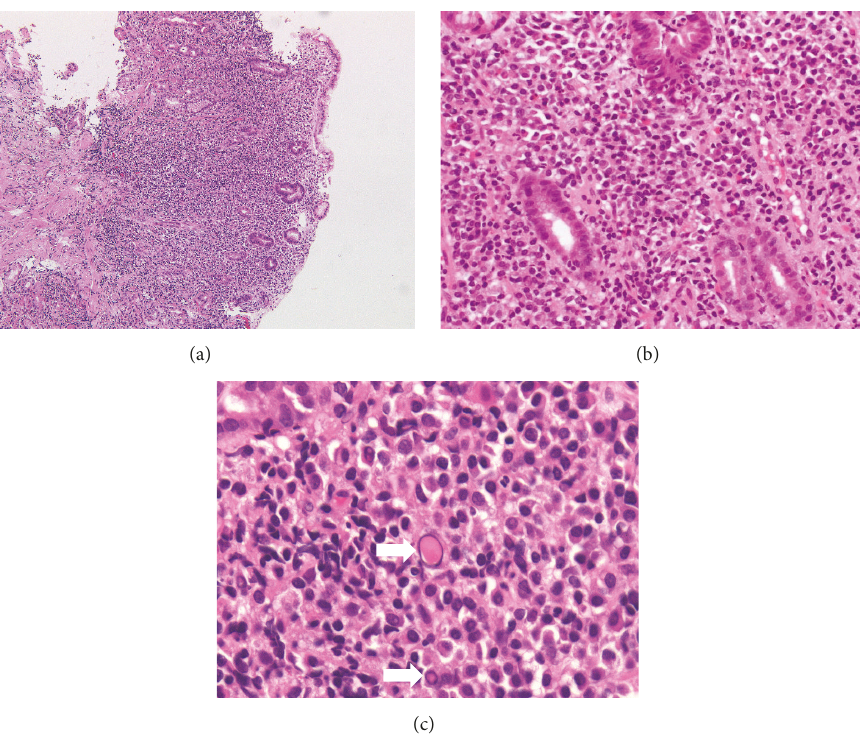
Figure 2: Pathological images. Hematoxylin and eosin staining shows dense, diffuse infiltration of small-to-medium-sized monocytoid cells and plasma cells (a, b) and multiple Dutcher bodies ((c)